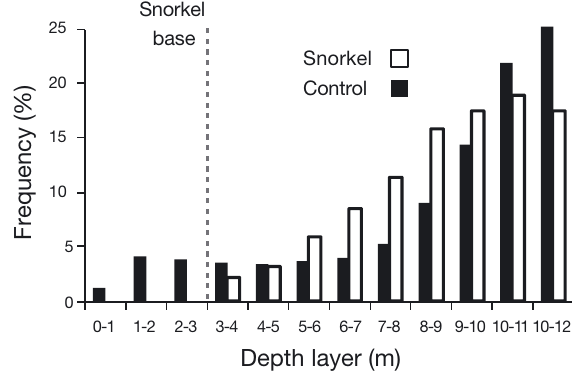
Fig. 4. Percentage of echo strength corrected for biomass (TS corr ) in Atlantic salmon by 1 m depth bands during the 55 d of snorkel installation given as means for the 3 snorkel and control cages for Expt 2. Dashed line: depth of snorkel cage roof, which was situated at the base of the snorkel